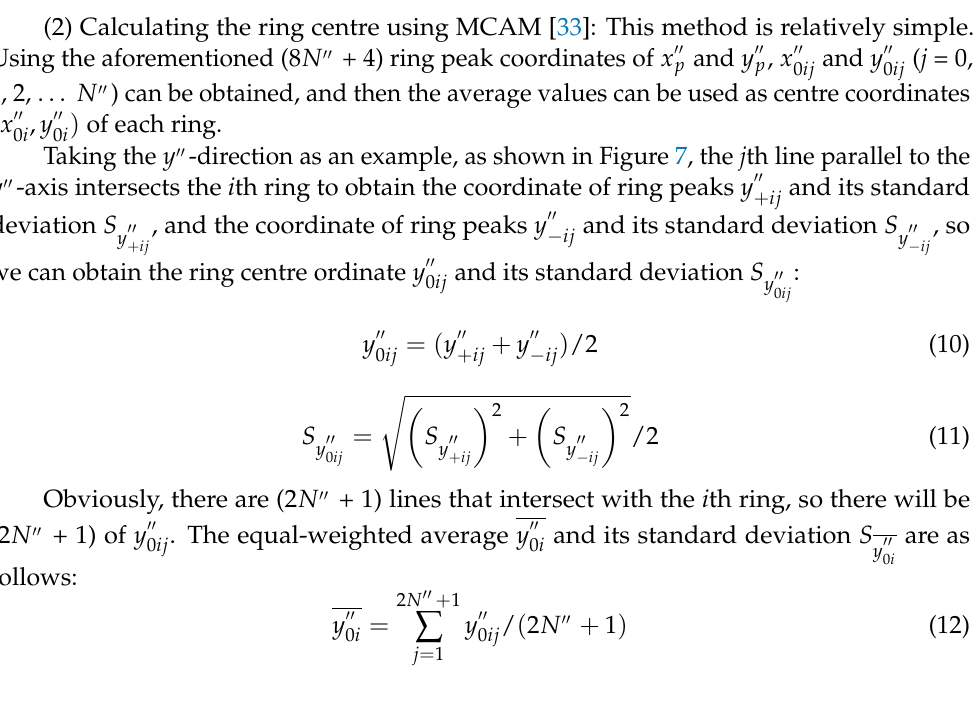
Figure 7. Multiple ring peak coordinates under line segments N